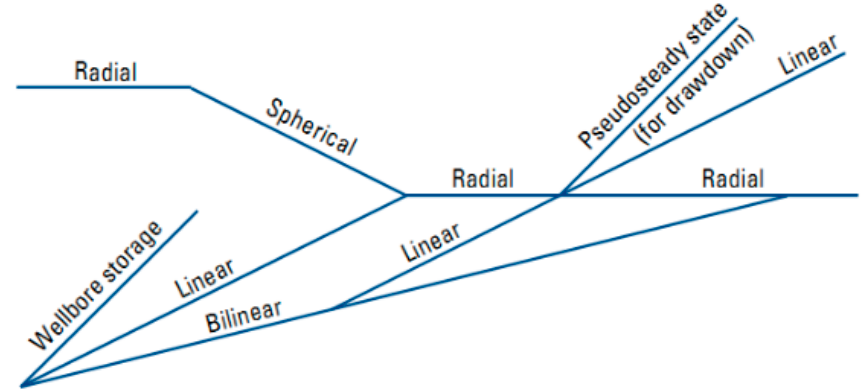
Figure 5. Flow regime identification tool. Reproduced with permission by the Oil & Gas journal from [17].